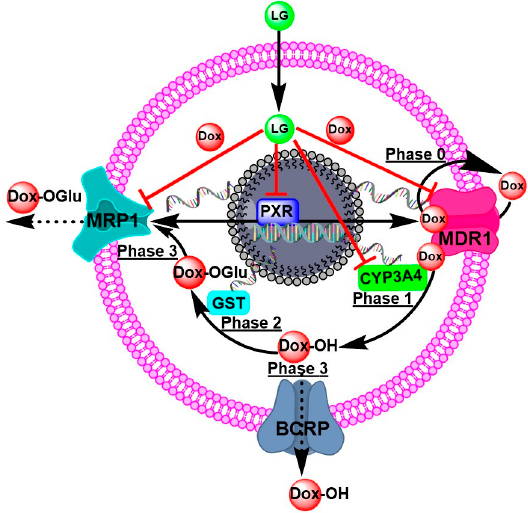
Figure 6. The proposed mechanisms of DOX-resistance and the targeting molecules of LG to overcome DOX-resistance Phase 0 is when P-gp/ABCB1/MDR1 takes up and effluxes the drug. Phases 1 and 2 are biotransformations, such as hydroxylation by CYP3A4 and conjugation by GST. Phase 3 is the transport of DOX-metabolites to the outside of cells for excretion.